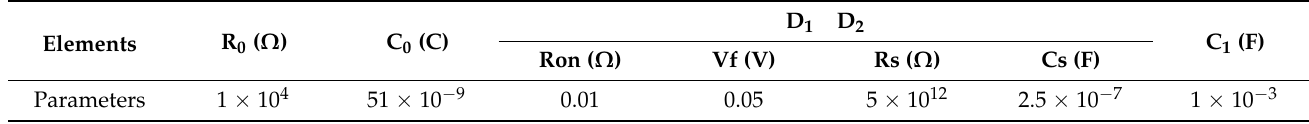
Figure 3. ( a ) Typical voltage waveform after rectification and ( b ) the voltage of the energy storage capacitor in the charging process. Table 1. Elements in the energy harvesting